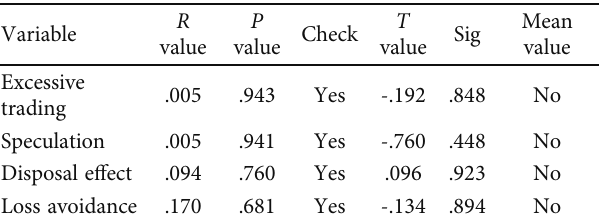
Table 6: Results of gender di ff erence t